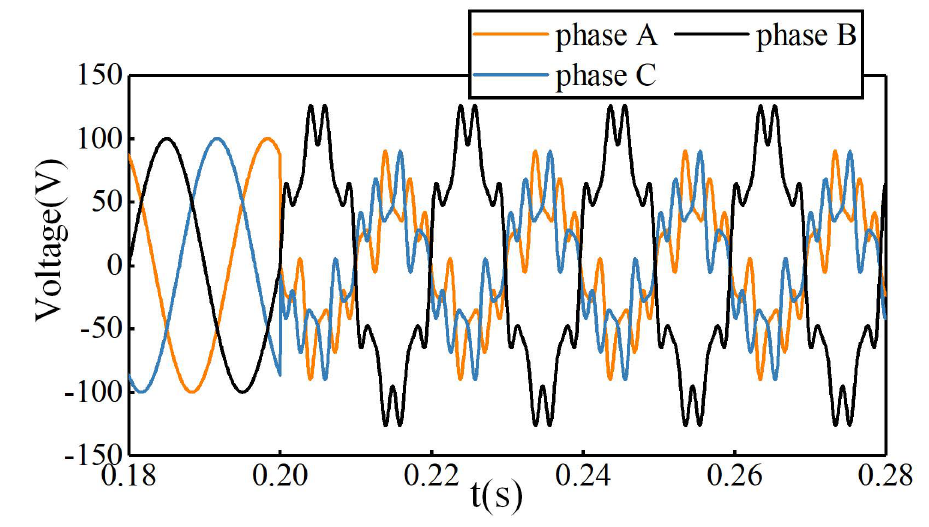
Figure 7. The grid voltage considered in the simulation.